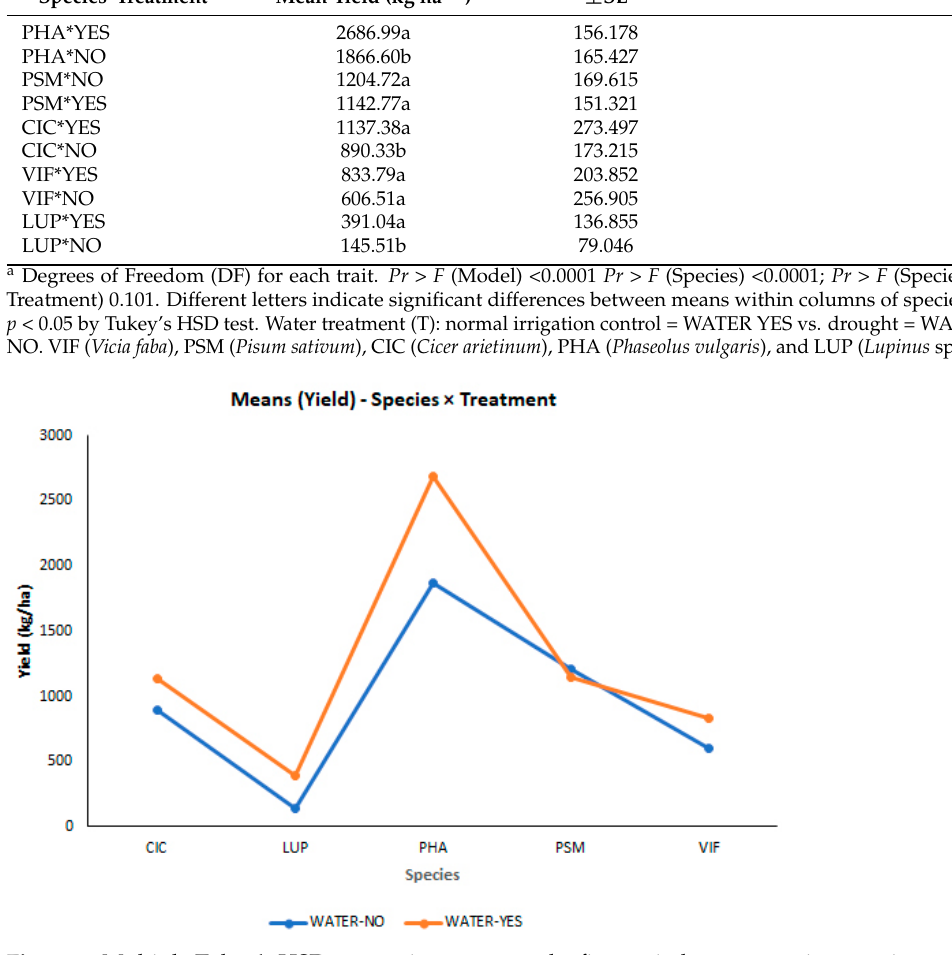
Figure 5. Multiple Tukey’s HSD comparisons among the five grain legume species growing under two water deficit treatments (normal irrigation control WATER YES vs. drought WATER NO) for seed yield (kg ha − 1 ). Table 4. Analysis of variance and Tukey’s HSD test among genotype varieties of the fi ve grain leg- ume species growing under the two environments (ENV3 and ENV4) and two water treatments for seed yield (kg ha − 1 ). The water treatments and their interactions were considered as fi xed e ff ects in the model.